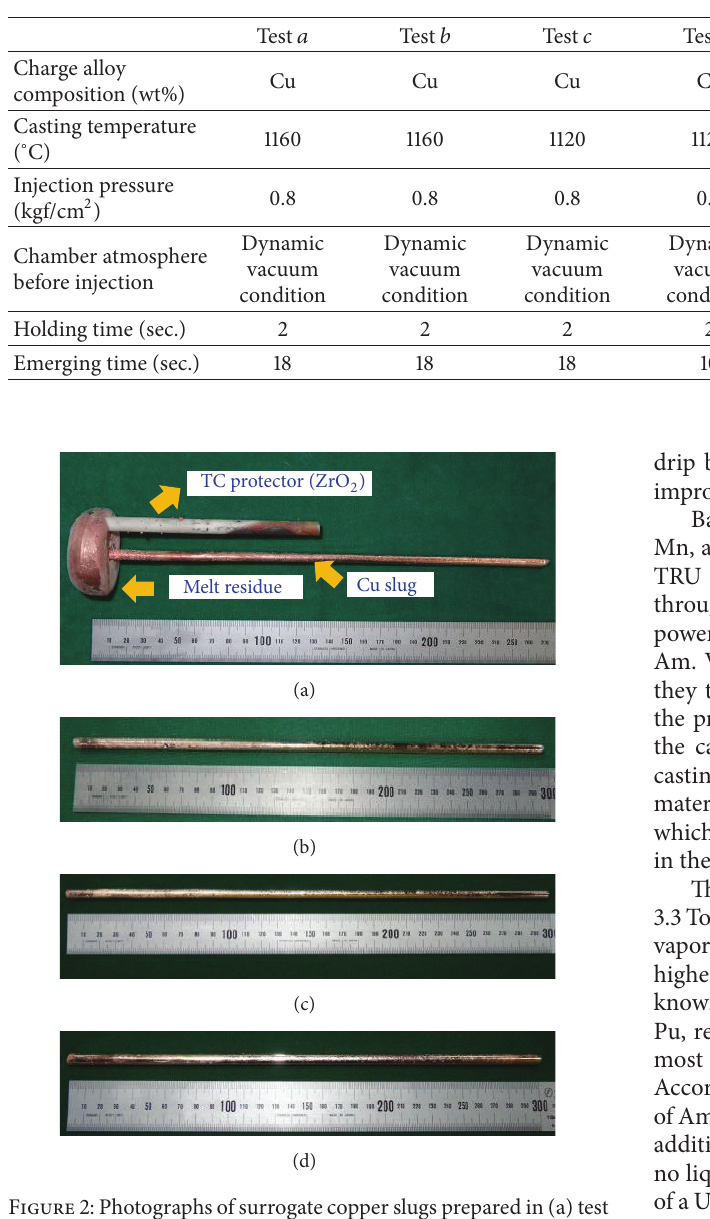
Table 1: Experimental parameters for injection casting of Cu and U–10Zr–5Mn fuel slugs.